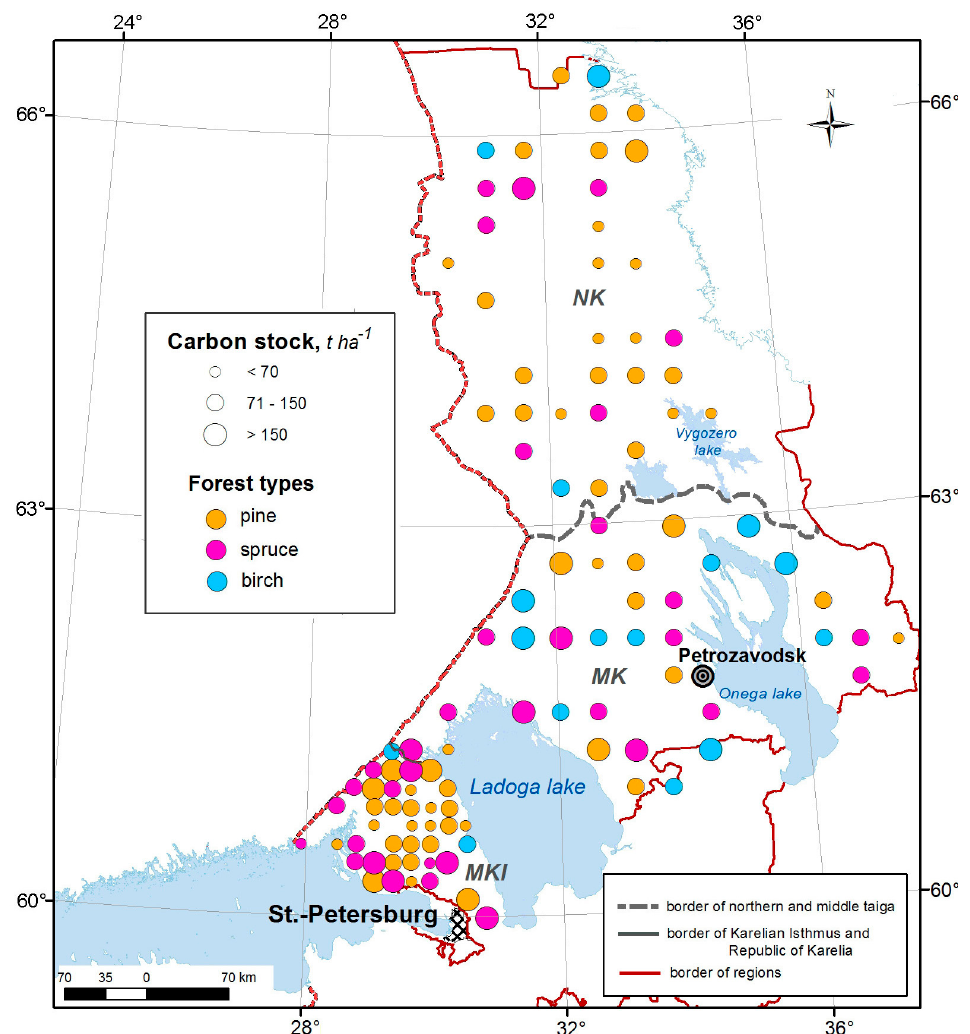
Figure 1. Soil carbon stocks in pine, spruce and birch forests at 109 monitoring plots. NK—northern taiga, Karelia, MK—middle taiga, Karelia, MKI—middle taiga, the Karelian Isthmus, Leningrad region.